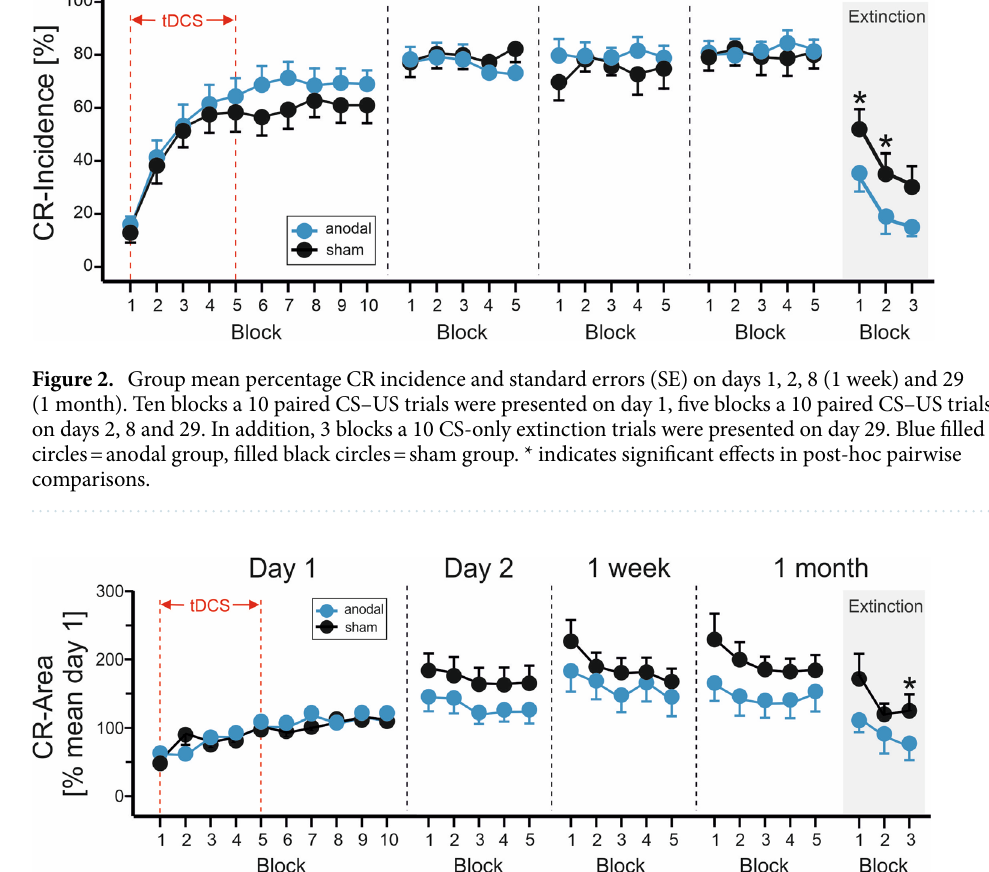
Figure 3. Group mean percentage CR area and standard errors (SE) on days 1, 2, 8 (1 week) and 29 (1 month). Ten blocks a 10 paired CS–US trials were presented on day 1, five blocks a 10 paired CS–US trials on days 2, 8 and 29. In addition, 3 blocks a 10 CS-only extinction trials were presented on day 29. Note that the number of participants per block varies because of lack of CRs in individual blocks. Blue filled circles = anodal group, filled black circles = sham group. * indicates significant effects in post-hoc pairwise